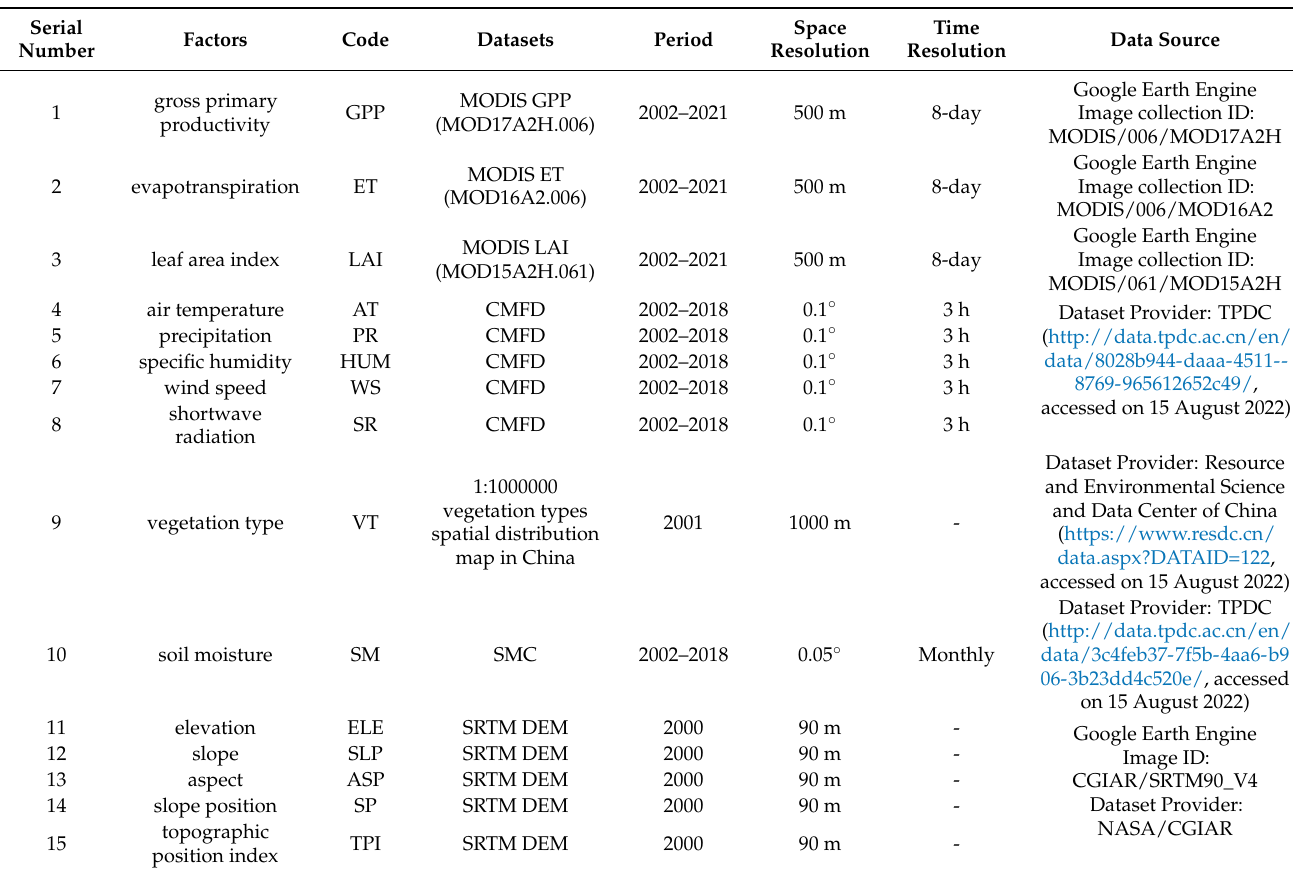
Table 1. Data description used in this study.